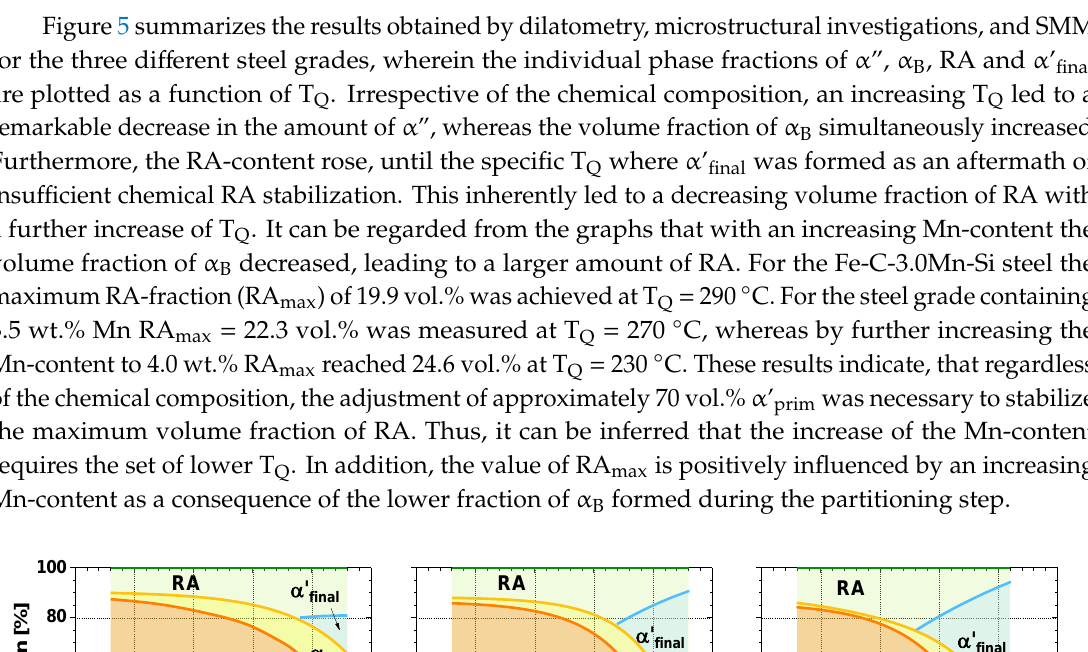
Figure 6. Stress-strain curves for the ( a ) Fe-C-3.0Mn-Si, ( b ) Fe-C-3.5Mn-Si and ( c ) Fe-C-4.0Mn-Si steels quenched to different T Q in order to adjust 50 vol.% (red), 75 vol.% (purple) and 85 vol.% ( blue) α’ prim .